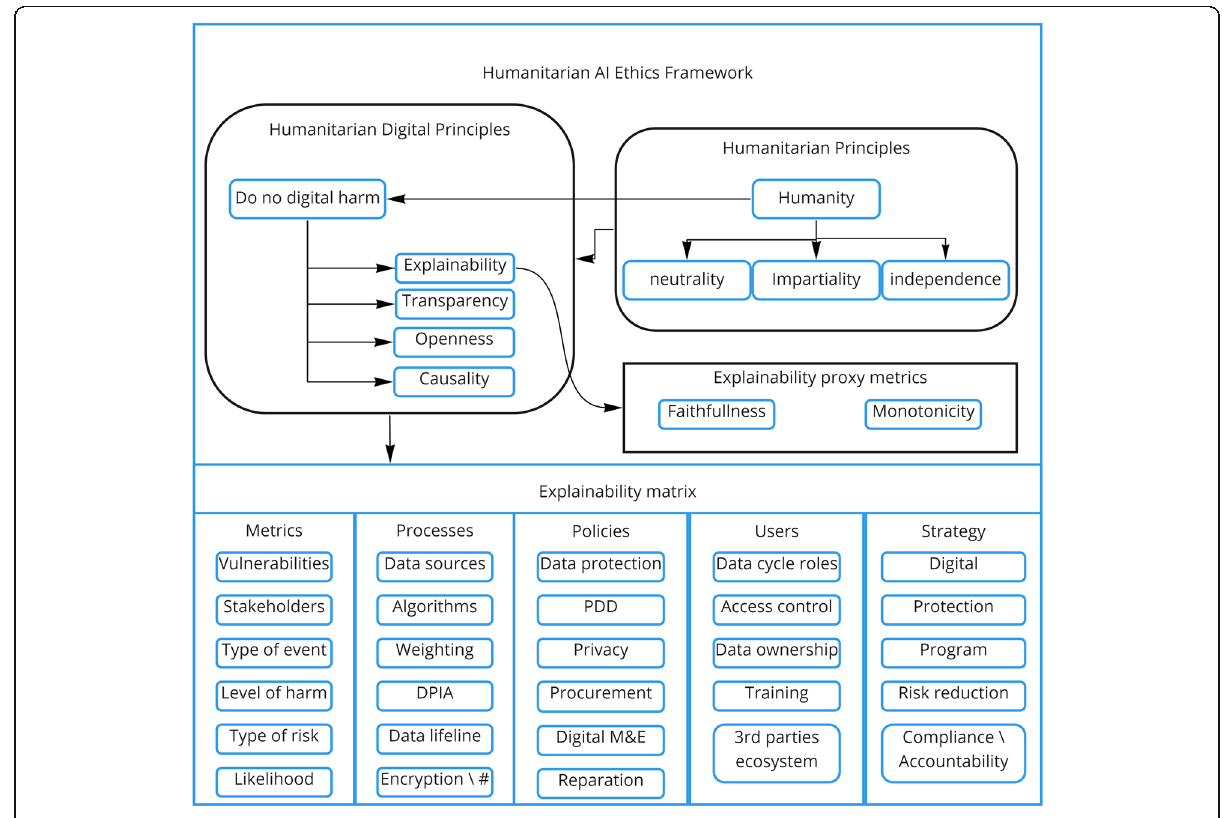
Fig. 3 Diagram of the proposal for a humanitarian AI ethics framework and explainability